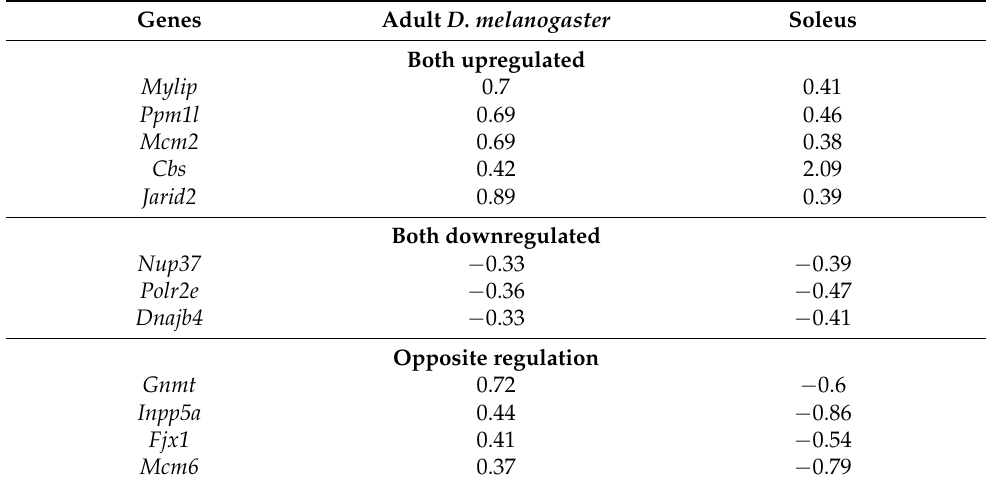
Table 4. DEGs shared between space flown adult D. melanogaster and soleus muscle and their direction of regulation. Values shown are Log2